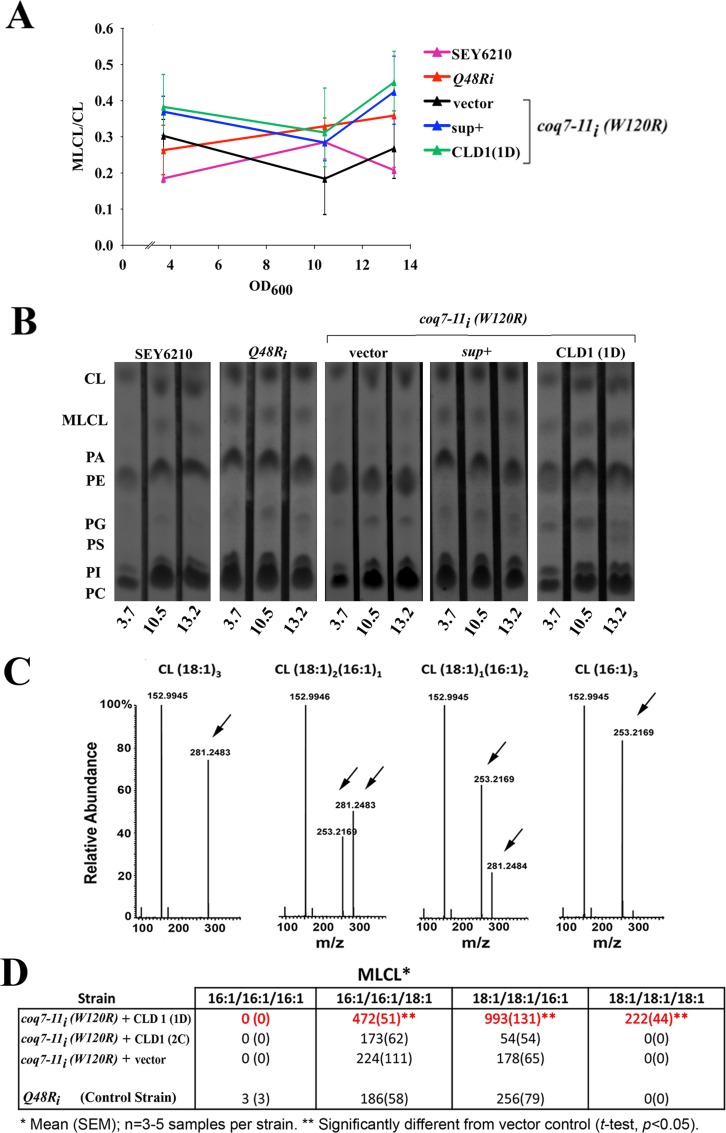
CLD1 overexpression alters whole-cell monolysocardiolipin content of coq7 hypomorphs.(A, B) Whole-cell lipid extracts were prepared from the indicated yeast strains following growth at 25°C in liquid YEPE3% to the indicated optical density (OD600). Lipids were analyzed by thin layer chromatography (TLC). In (A), average MLCL/CL ratios (+/- range) are plotted for duplicate independent experiments, with triplicate technical replicates assayed at each OD600, in each experiment. Multiple regression analysis (S2 Table) revealed a significant (p<0.007) increase in the MLCL/CL ratio in coq7-11i(W120R) yeast following overexpression of Cld1p (1D and sup+). In (B) representative, raw TLC data is shown. CL, cardiolipin; MLCL, monolysocardiolipin; PA, phosphatidic acid; PE, phosphatidylethanolamine; PG, phosphatidylglycerol; PS, phosphatidylserine; PI, phosphatidylinositol; PC, phosphatidylcholine. (C) MLCL derivatives were extracted from yeast cultured at 25°C to mid-log phase (OD600 ~7), then analyzed by HPLC-ESI-MS/MS. m/z for [M-H]- of CL(16:1/16:1/16:1), CL(16:1/16:1/18:1), CL(18:1/18:1/16:1) and CL(18:1/18:1/18:1) used for quantification are m/z 1107.6884, 1135.7196, 1163.7510 and 1191.7823, respectively. Arrows indicate C16:1 and C18:1 peaks used for MS1 identification. (D) Absolute quantitation of MLCL species in mid-log phase of the indicated yeast strains (pmole per 35ml culture volume, OD600 7.0). Data is presented as mean (+/- SEM), n = 4–5 independent replicates per strain. Significance testing was undertaken using Student’s t-test p<0.05). Overexpression of wild type CLD1 (amplicon 1D) in the coq7-11i(W120R) background leads to a shift in C18:1 enriched MLCL species. This shift was not observed when the non-suppressing cld1(W170R) point mutant (encoded by amplicon 2C) was overexpressed, suggesting this allele either directly or indirectly results in an enzymatic loss-of-function protein.